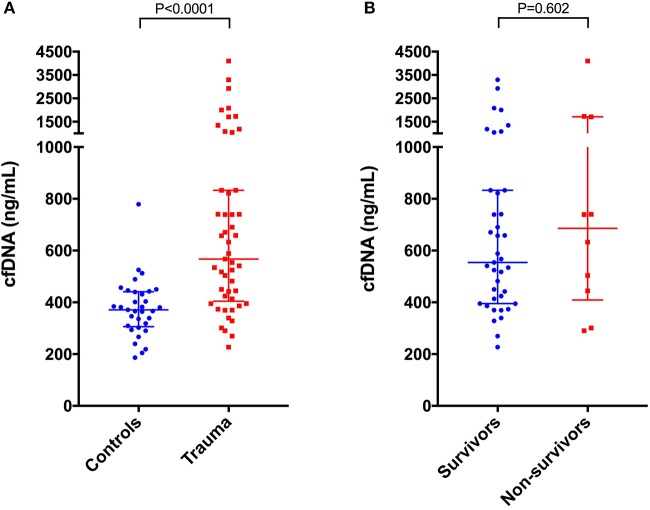
Scatterplots of plasma cell-free DNA (cfDNA) in (A) healthy controls (n = 33) compared to dogs following moderate-severe trauma (n = 49), and in (B) survivors (n = 39) compared to non-survivors (n = 10). The central horizontal line represents the median, and the two error bars represent the interquartile range. Comparisons between the groups were performed using the Mann-Whitney U test. P < 0.05 was considered significant.